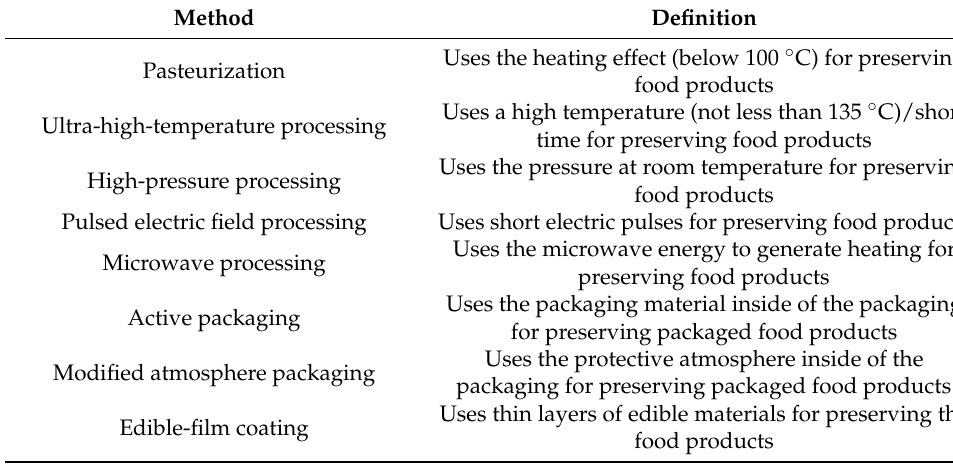
Table A1. Statements used in informative